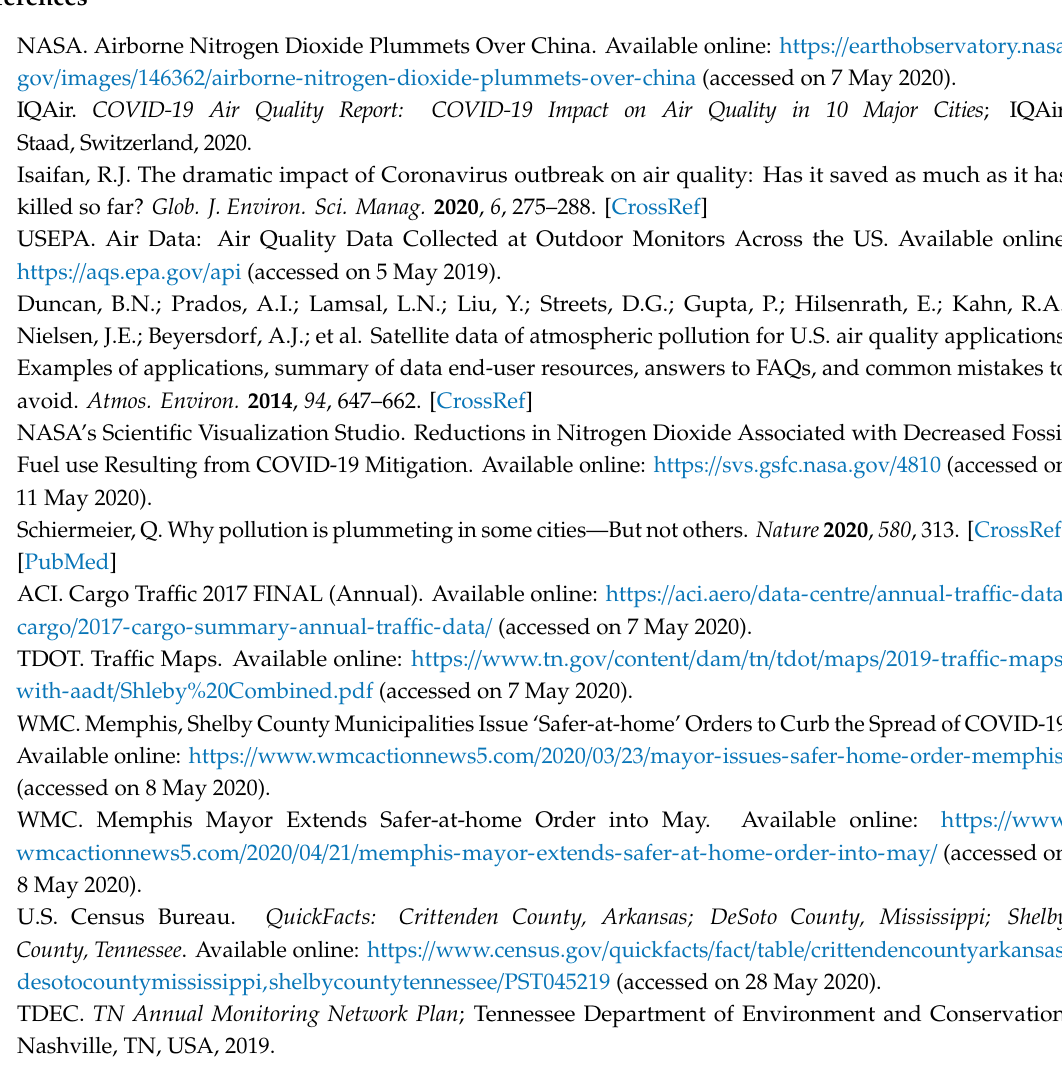
Figure S1: Daily average concentrations of criteria air pollutants and weather conditions in the Greater